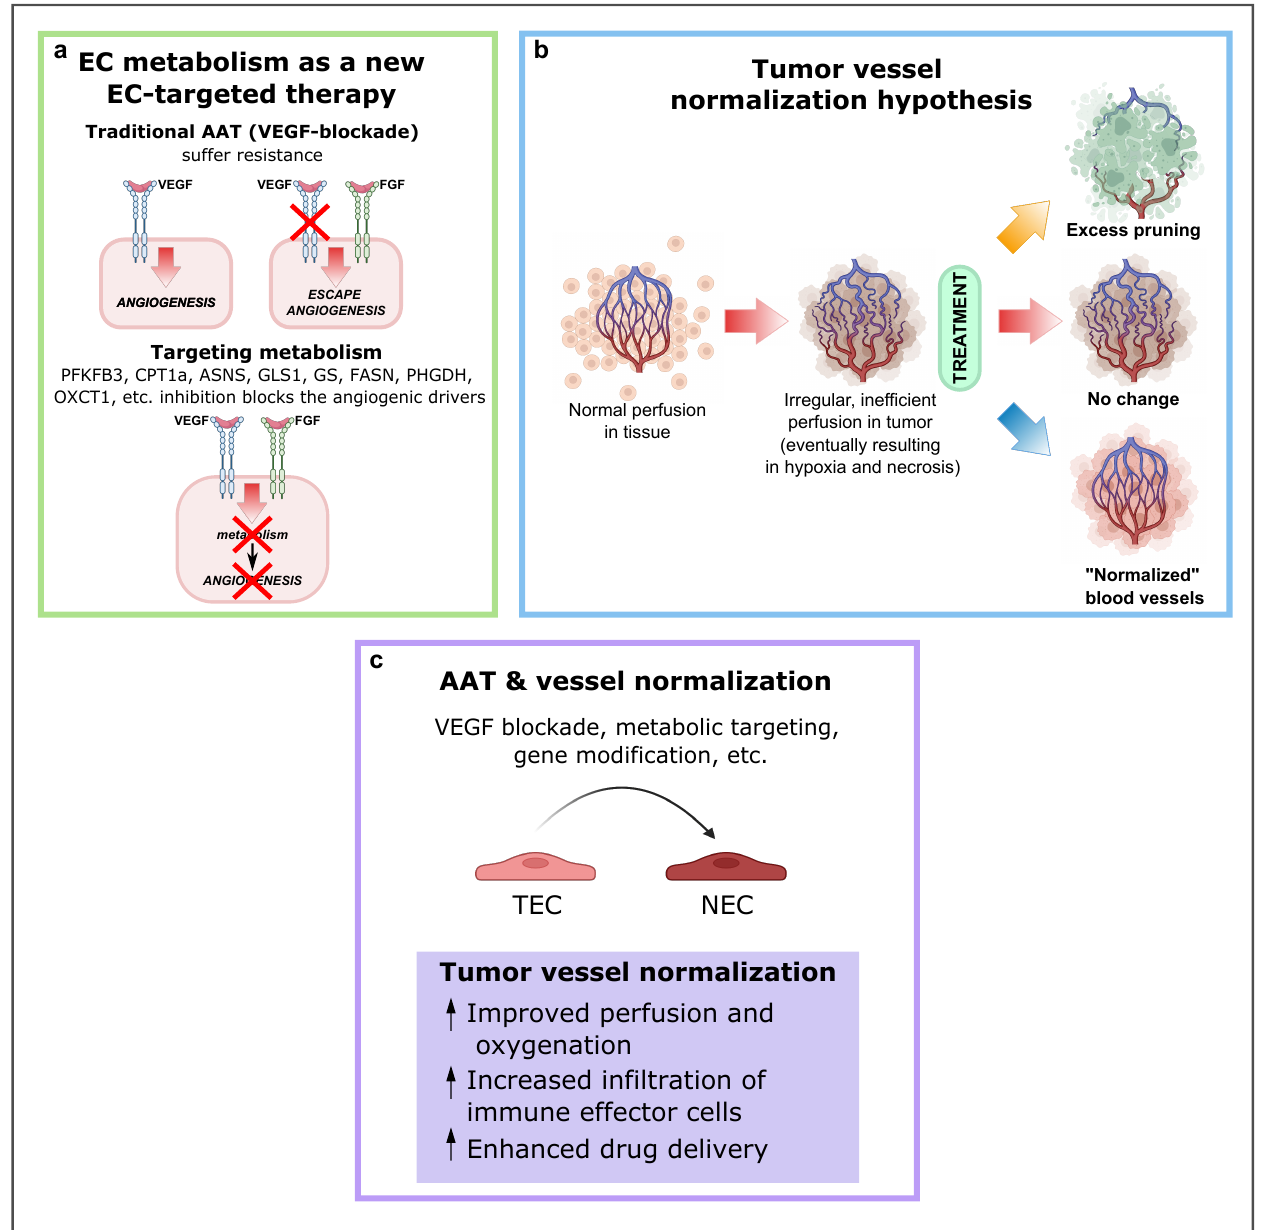
Figure 4. EC metabolism as a new EC-targeted therapy approach, tumor vessel normalization and alternative improved AAT in combination with other antitumor drugs. ( a ) Targeting EC metabolism as an alternative method to block pathological angiogenesis. While current anti-VEGF therapy com- pensatorily induces other angiogenic drivers (alternative growth factors), targeting EC metabolism, an engine driving angiogenesis, impairs vessel growth, regardless of how many angiogenic signals are present. Reproduced from [1] using BioRender.com. ( b ) Depending on the type and intensity of antiangiogenic therapy (AAT), the tumor vasculature can be pruned, leading to decreased blood perfusion (top); not respond to therapy (center); or become “normalized,” resulting in increased blood perfusion (bottom). Reproduced from Sorensen et al. [120] using BioRender.com. ( c ) Consequences and effects of AAT and vessel normalization. Abbreviations: EC, endothelial cell; VEGF, vascular endothelial growth factor; PFKFB3, phosphofructokinase-2/fructose-2,6-bisphosphatase 3; CPT1A, carnitine palmitoyltransferase 1A; ASNS, asparagine synthetase; GLS1, glutaminase; GS, glutamine synthase; FASN, fatty acid synthase; PHGDH, phosphoglycerate dehydrogenase; OXCT1, 3-oxoacid CoA-transferase 1; AAT, antiangiogenic therapies; TEC, tumor endothelial